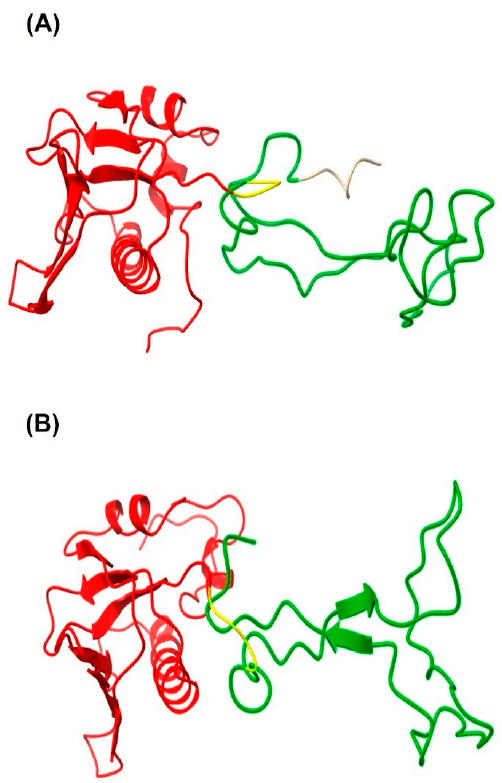
Figure 2. A 3D structure model of the candidate vaccine LTB-RBD targeting the Wuhan sequence ( A ) or delta variant ( B ). The full-length sequence of LTB (red) fused to an RBD segment (aa 439–504, green). GPGP linker (yellow) placed between the LTB and RBD domains. The His tag is only present in LTB-RBD Wuhan. These structures were modeled with the Phyre2